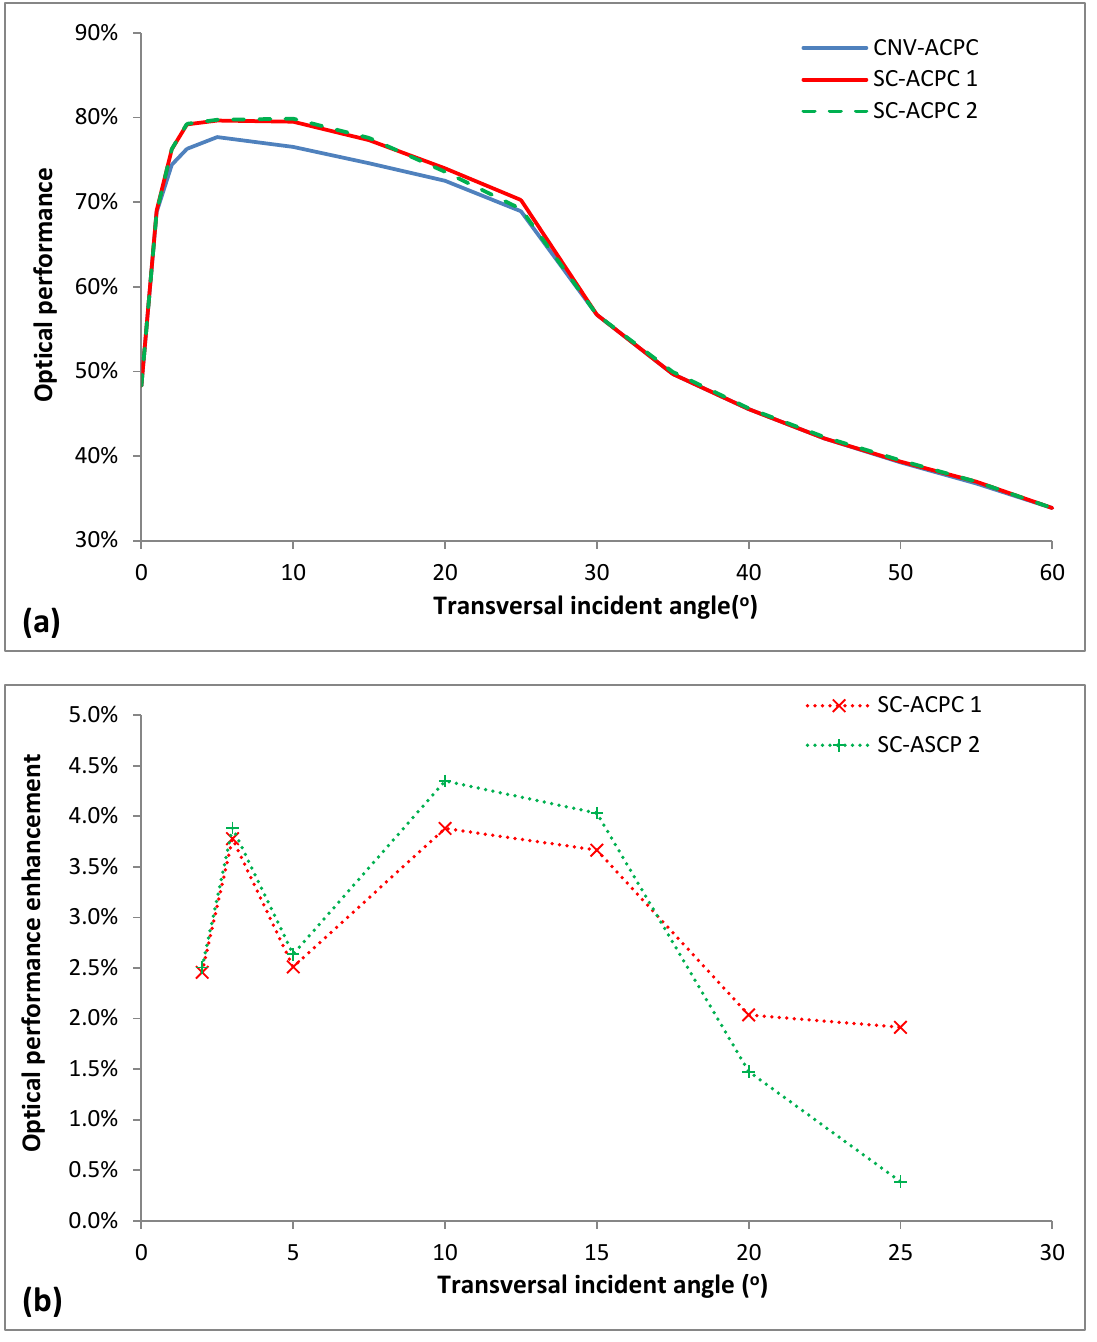
Figure 8. Optical performance comparison ( a ) Optical performance and ( b ) Enhancement.